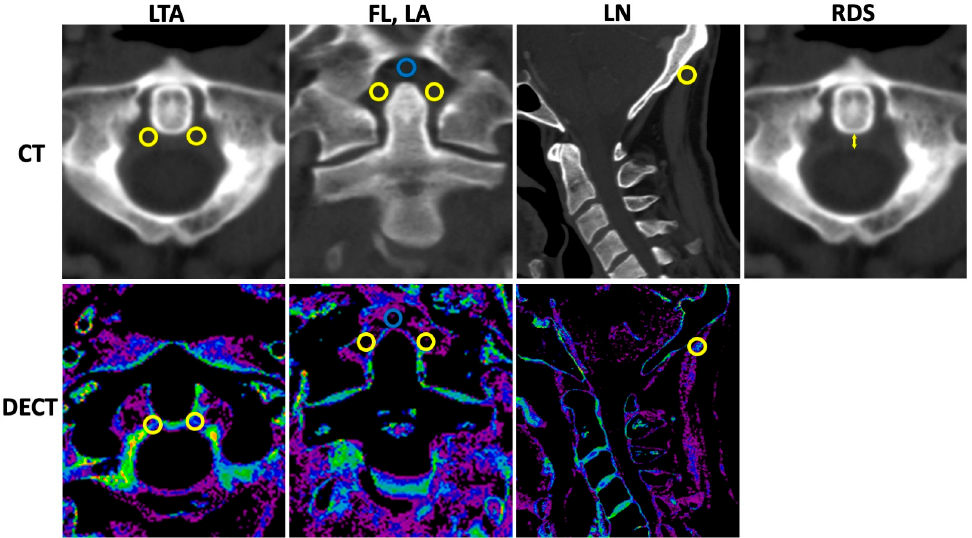
Figure 1. Measurement of collagen density and retro-odontoid soft tissue. CT = computed tomography, DECT = dual-energy CT, LTA = ligamentum transversum atlantis, FL = fasciculi longitudinalis, LA = ligamenta alaria, LN = ligamentum nuchae, and RDS = retro-odontoid soft tissue thickness. Upper row indicates CT with 135 kVp reconstructions. Lower row refers to DECT-based collagen maps. Region of interest (ROI) measurements were performed with predefined size of 9.5 mm 2 for all measurements using the collagen density maps. In total, twelve ROI measurements were performed (six in 135 kVp images, six in collagen maps) as follows: LTA (two ROIs per reconstruction in axial orientation (left and right orientation, yellow ROIs); FL (one ROI per reconstruction in coronal orientation, blue ROI); LA (two ROIs per reconstruction in coronal orientation, yellow ROIs); and LN (one ROI per reconstruction in sagittal orientation, yellow ROI). Thickness of the retro-odontoid soft tissue (indicated by the yellow arrow) was measured using the 135 kVp CT reconstruction in axial